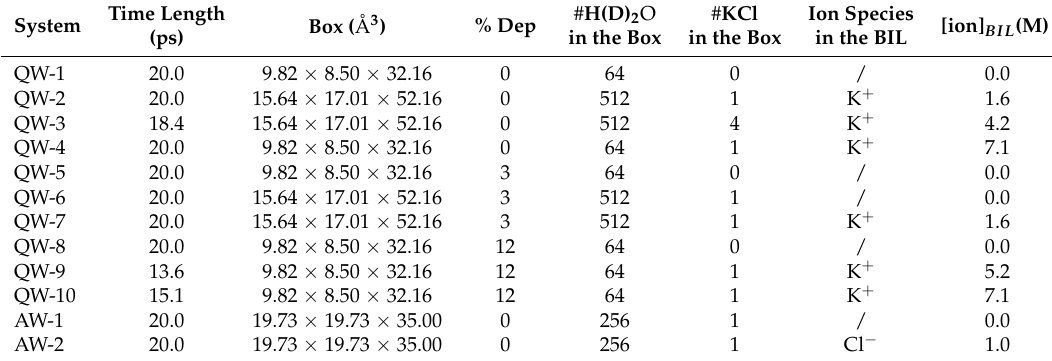
Table 1. Details of the simulations performed in this work. QW stands for the α -(0001) quartz–water interface and AW for the air–water interface. “% dep” means % deprotonation of the quartz surface hydroxyls. BIL is the Binding Interfacial